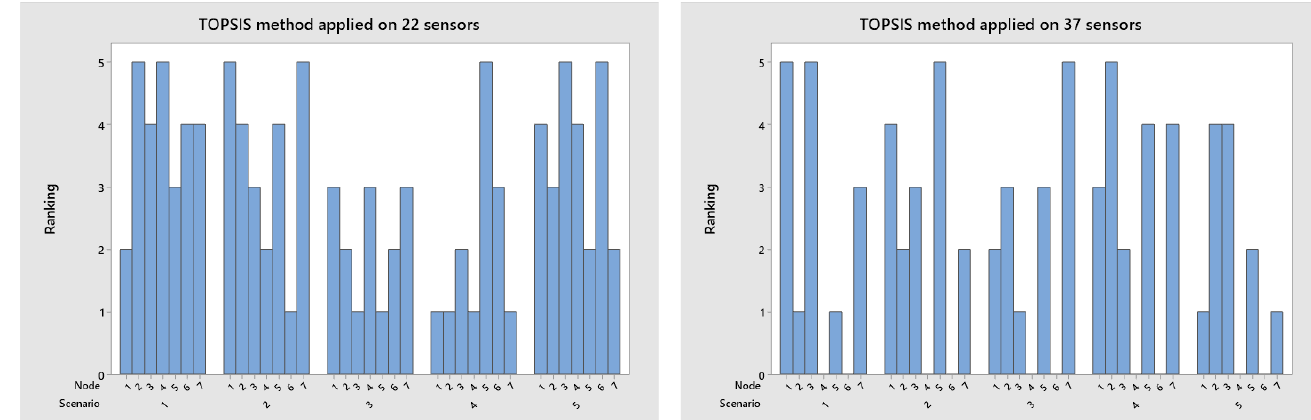
Figure 6. Rank applied SAW algorithm for the network with 22 and 37 nodes.